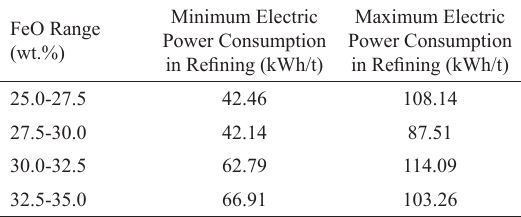
Table 2: Extremes values obtained from electric power consumption for the main FeO ranges. FeO Range (wt.%)